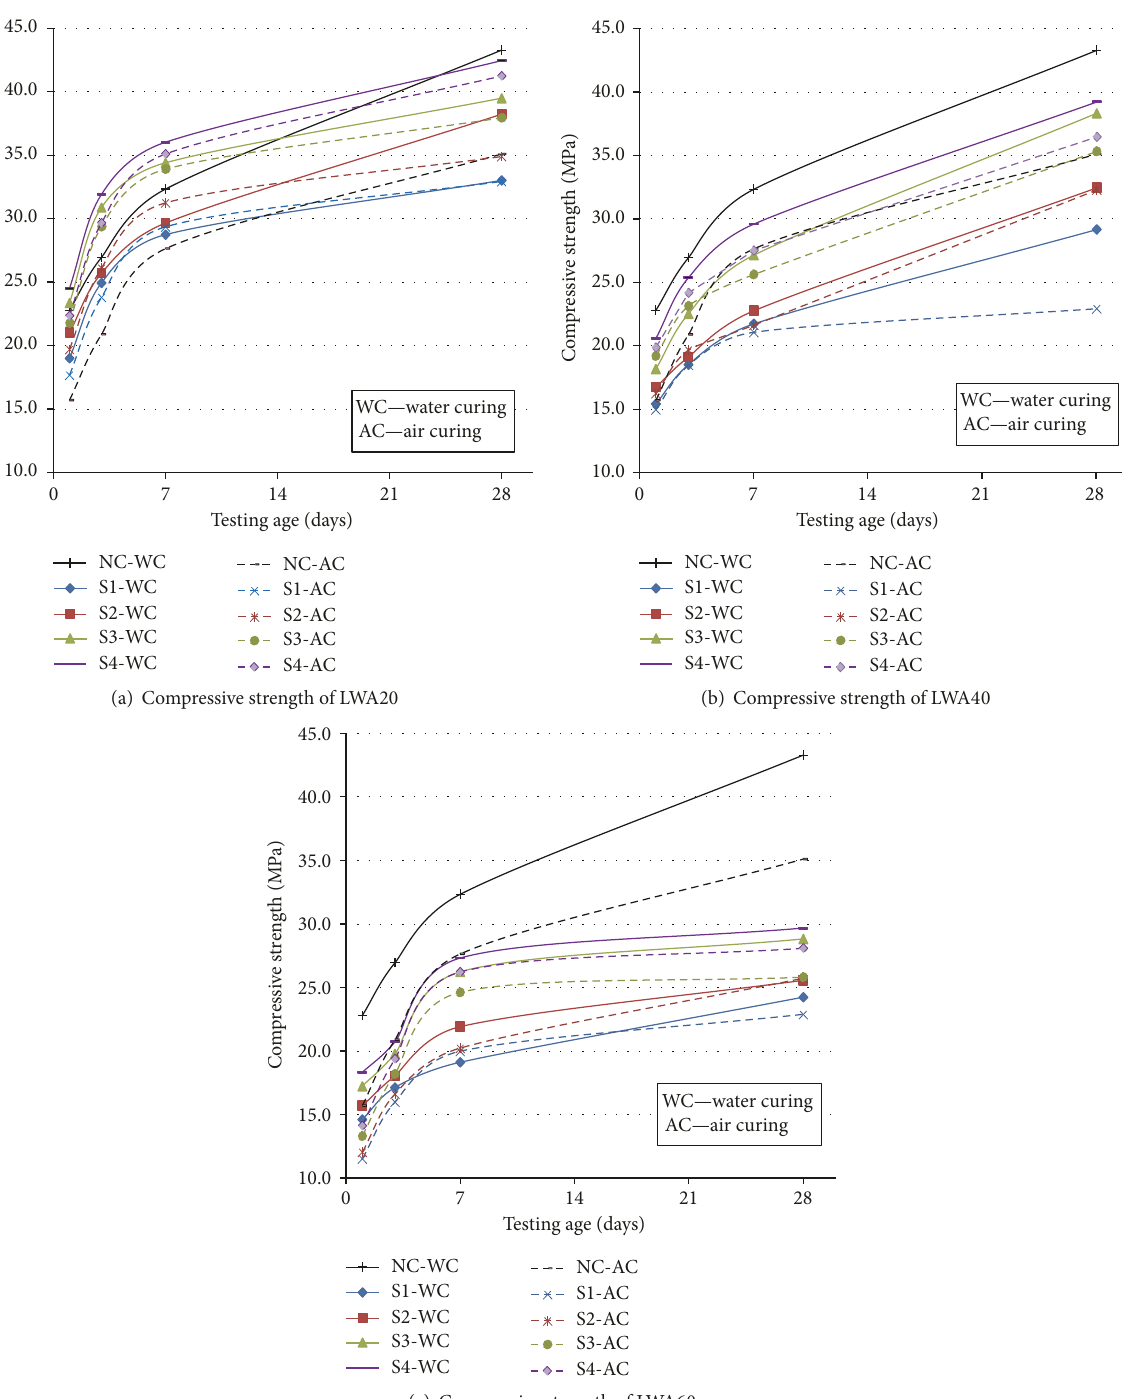
Figure 11: Standard compressive strength test of NC and AAC-LWA concrete in different size classes (S1 to S4) at the age of 1, 3, 7, and 28